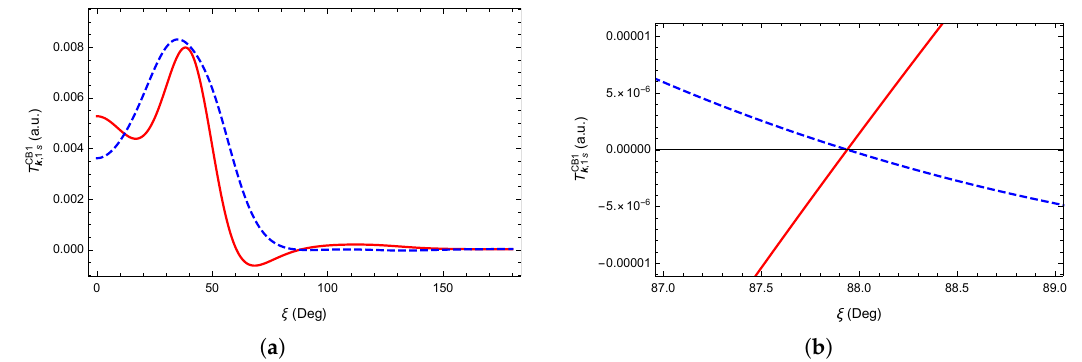
Figure 2. Transition matrix element, T CB1 , versus the polar angle ξ for electron-impact ionization k ,1 s ] (solid red line) and Im [ T CB1 ] (dashed blue line) over the full of hydrogen at 76.4541 eV. ( a ) Re [ T CB1 k ,1 s k ,1 s ] (solid red line) and Im [ T CB1 ] (dashed blue line) in the vicinity of the zero angular range ( b ) Re [ T CB1 k ,1 s k ,1 s in T CB1 . k ,1 s